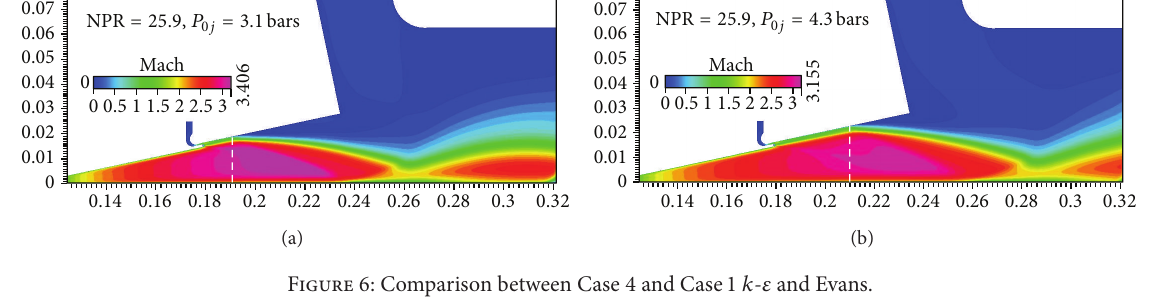
Figure 5: Calculated Mach number fields for Cases 1, 2, and 3.